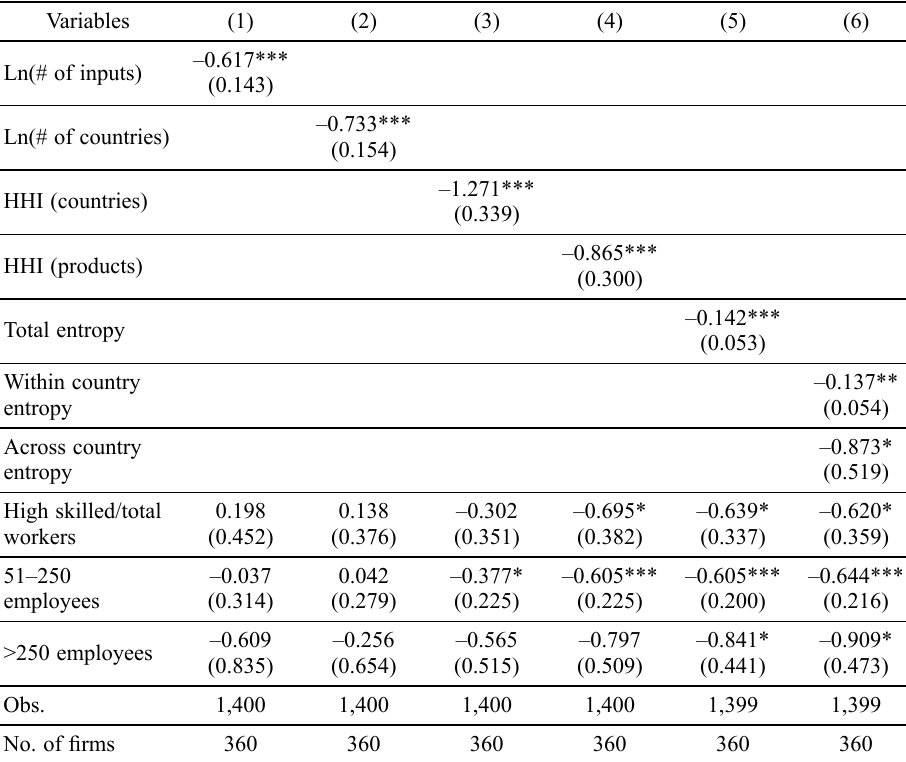
Table 2. The influence of global sourcing on firms’